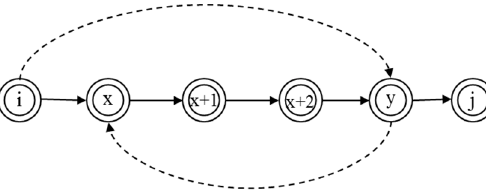
Figure 7. The schematic diagram of delay caused by charging order.